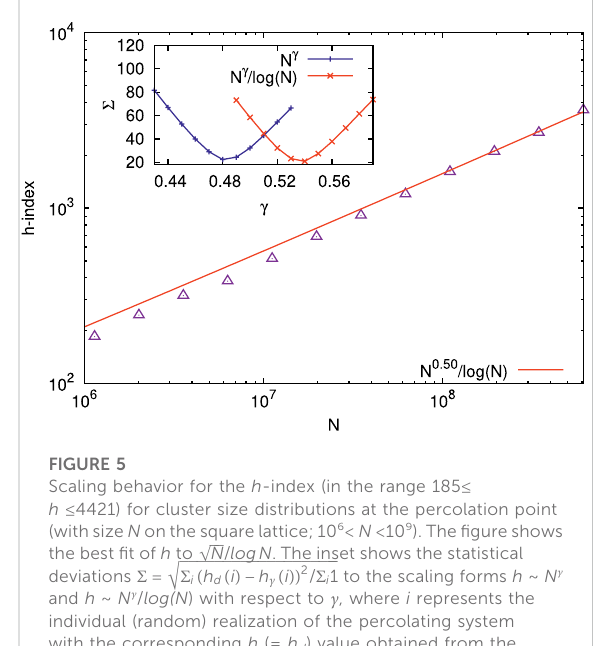
(cid:1)(cid:1)(cid:1) √ N c , c